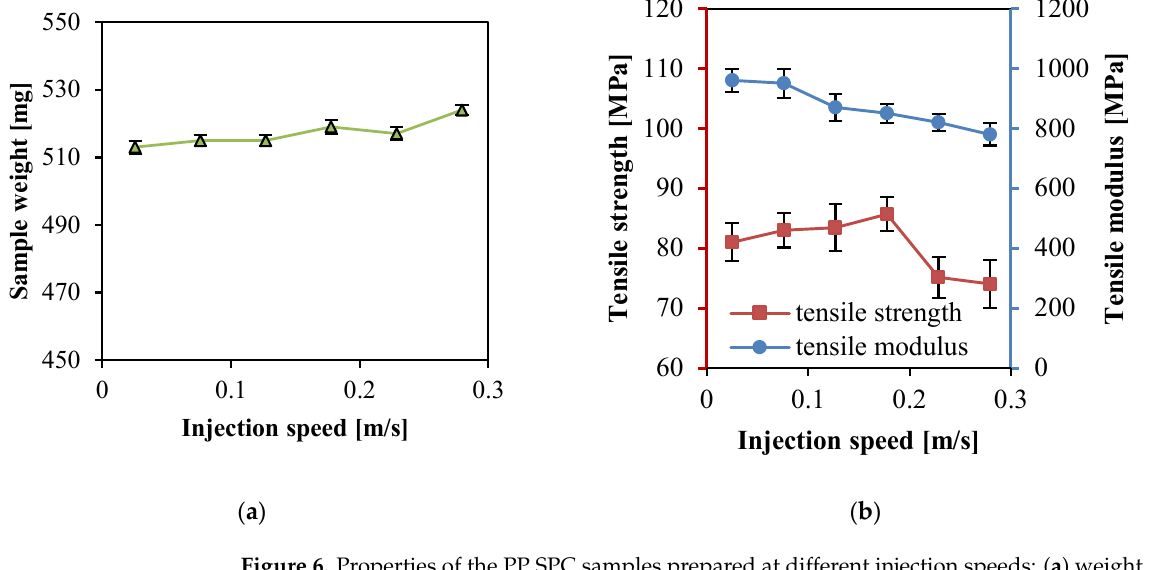
Figure 6. Properties of the PP SPC samples prepared at different injection speeds: ( a ) weight, and ( b ) tensile and tensile modulus.